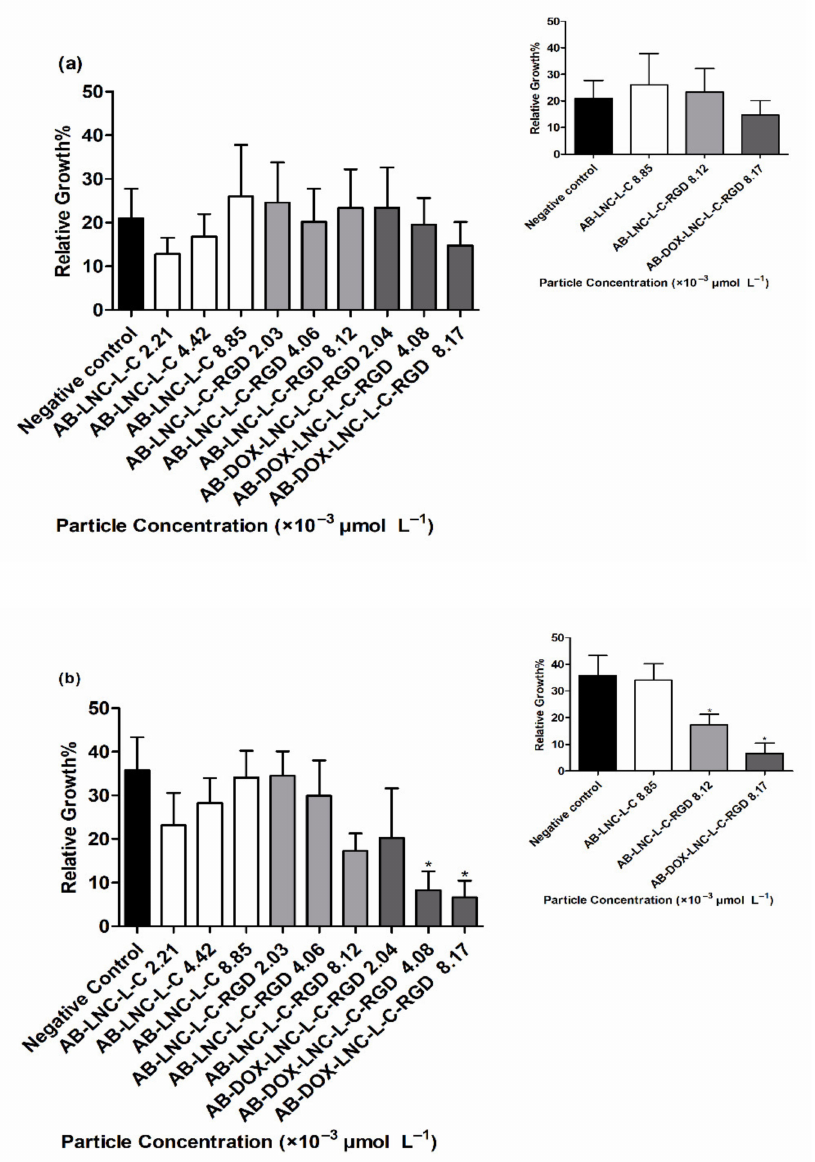
Figure 5. Relative vessel growth in chicken embryo CAM after ( a ) 24 h of treatment and ( b ) 48 h of treatment. Inset: Relative vessel growth following treatment at the highest concentrations of AB-LNC- L-C, AB-LNC-L-C-RGD, and AB-DOX-LNC-L-C-RGD. Data are expressed as the mean ± SEM. ( n = 3) * represents the statistical difference with respect to the negative control ( p < 0.05) (ANOVA,